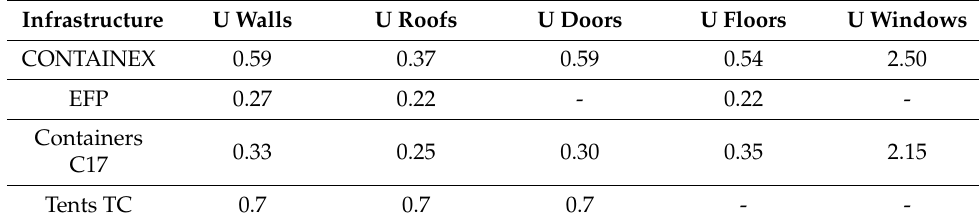
Table 1. Thermal transmittance (W/m 2 K) of different living spaces in military